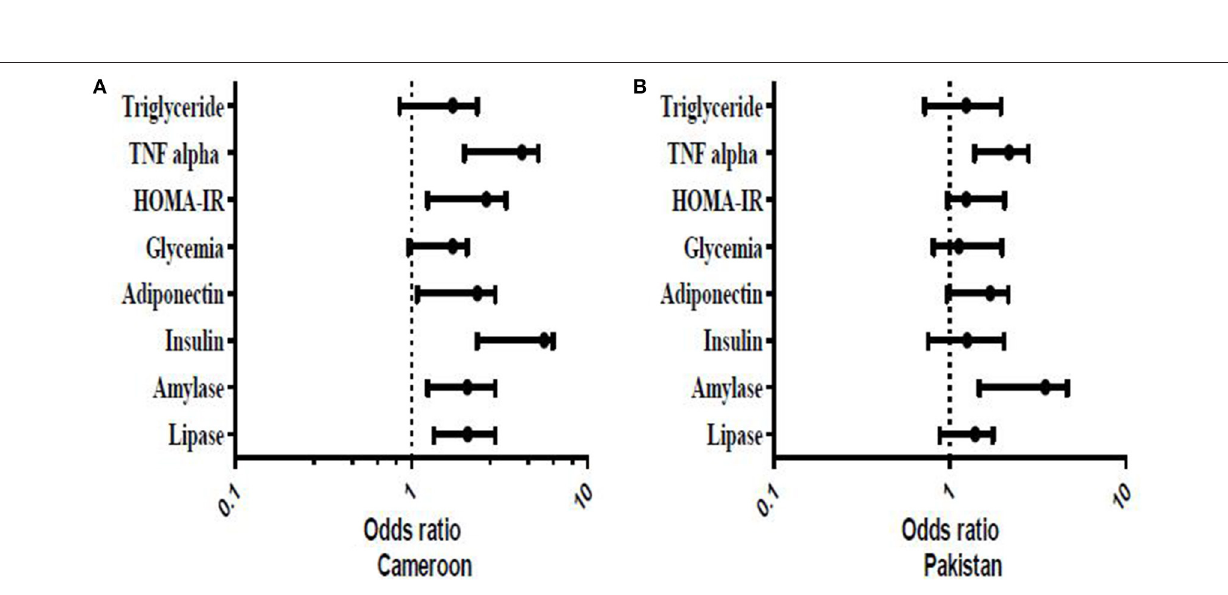
TNF-alpha levels were 179.02 IU/L, 51.34 IU/L, 21.17 µ IU/mL, 4.47 µ g/mL, 219.36 mg/dL 1.48 g/L, and 21.24 pg/mL respectively for the Pakistani population and 197.67 IU/L, 48.08 IU/L, 28.42 µ IU/mL, 2.34 µ g/mL, 203.61 mg/dL, 1.16 g/L,